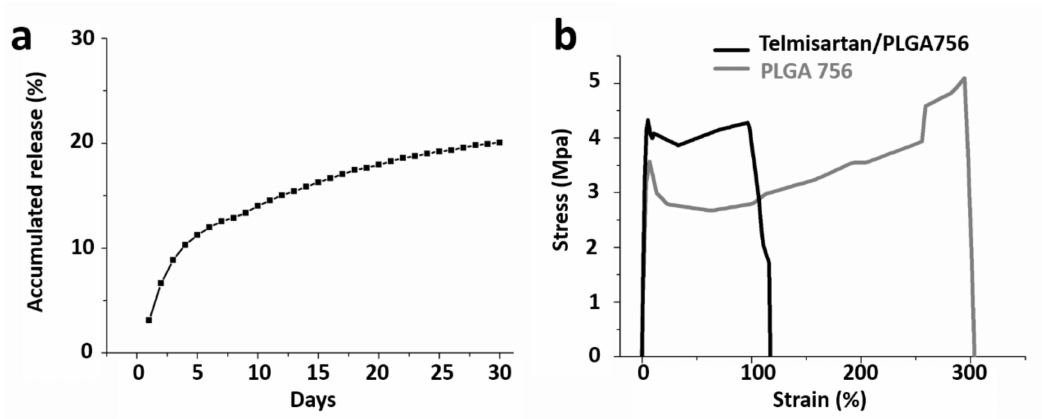
Figure 3. ( a ) Accumulated release of telmisartan and ( b ) stress–strain curves of telmisartan-loaded and plain PLGA 756 nanofibrous